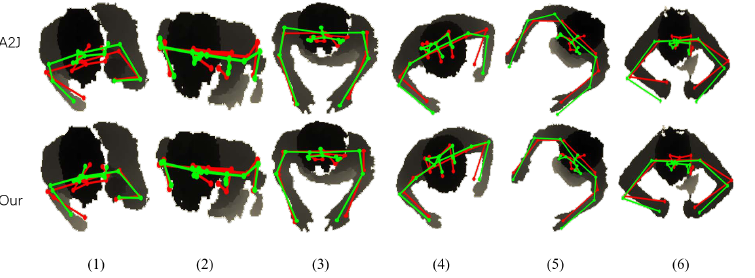
Figure 7. The comparison visualization results with A2J in the 2D plane on the ITOP top dataset. The ground-truth is shown in red, and the estimated result is in